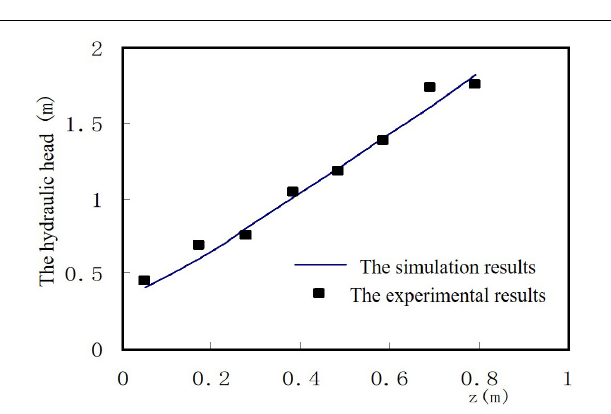
FIGURE 3 | The hydraulic head distributions with z under low recharge condition.